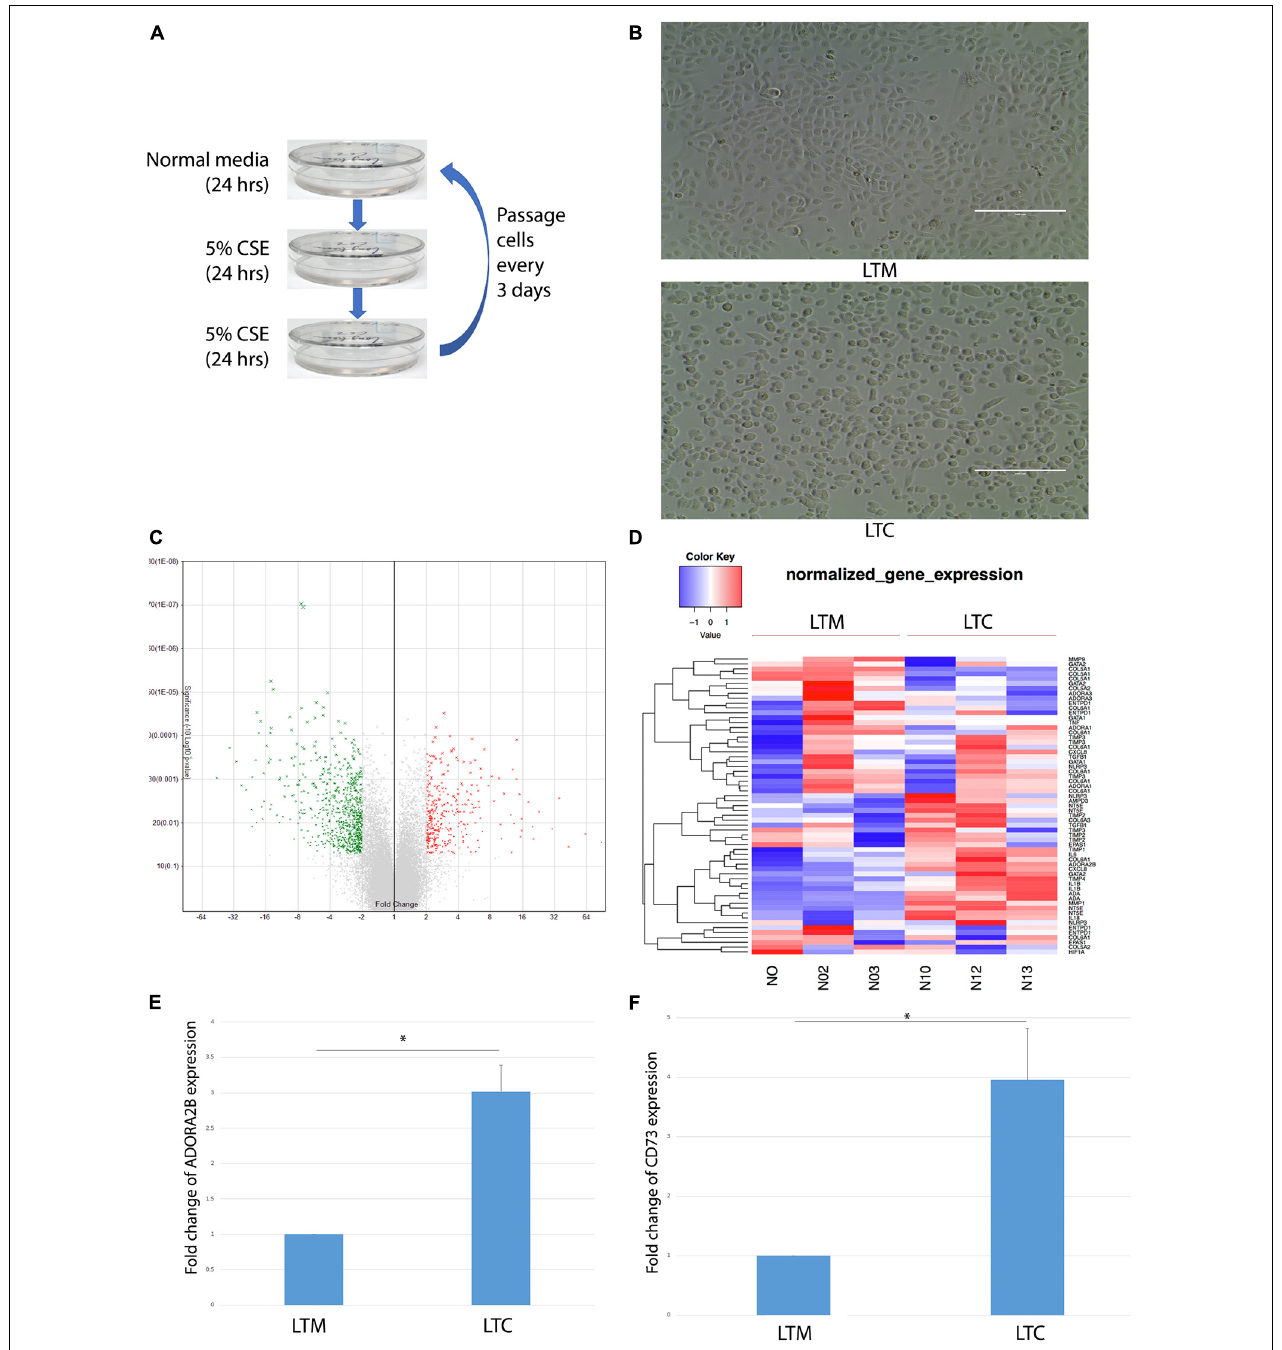
FIGURE 1 | (A) Workflow of long-term CSE exposure. (B) Morphological changes observed in LTC. Scale bar, 100 µ m. (C) Volcano plots showed that over 1,000 genes changed at least twofold after long-term CSE exposure. Red indicates up-regulated and green indicates down-regulated genes. (D) Heat map of up- or down- regulated wound repair related genes that are differentially expressed ( > twofold) in LTC. Red indicates up-regulated and blue indicates down-regulated genes as shown in the scale bar. (E) ADORA2B expression level up-regulated after long-term CSE exposure * indicated p < 0.05. (F) CD73 expression level up-regulated after long-term CSE exposure * indicated p <